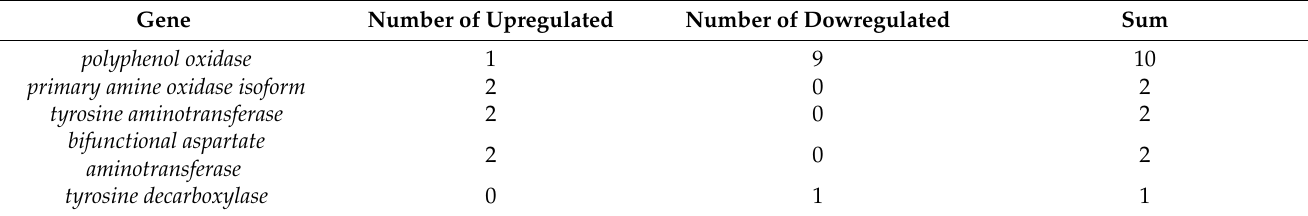
Table 4. DEGs related to tyrosine, phenylalanine and tryptophan metabolism in the GL libraries. Gene Number of Upregulated Number of Dowregulated Sum polyphenol oxidase 1 9 10 primary amine oxidase isoform 2